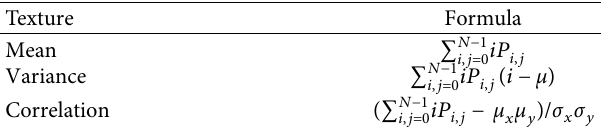
Figure 4: Distribution of acquisition dates of SAR and optical